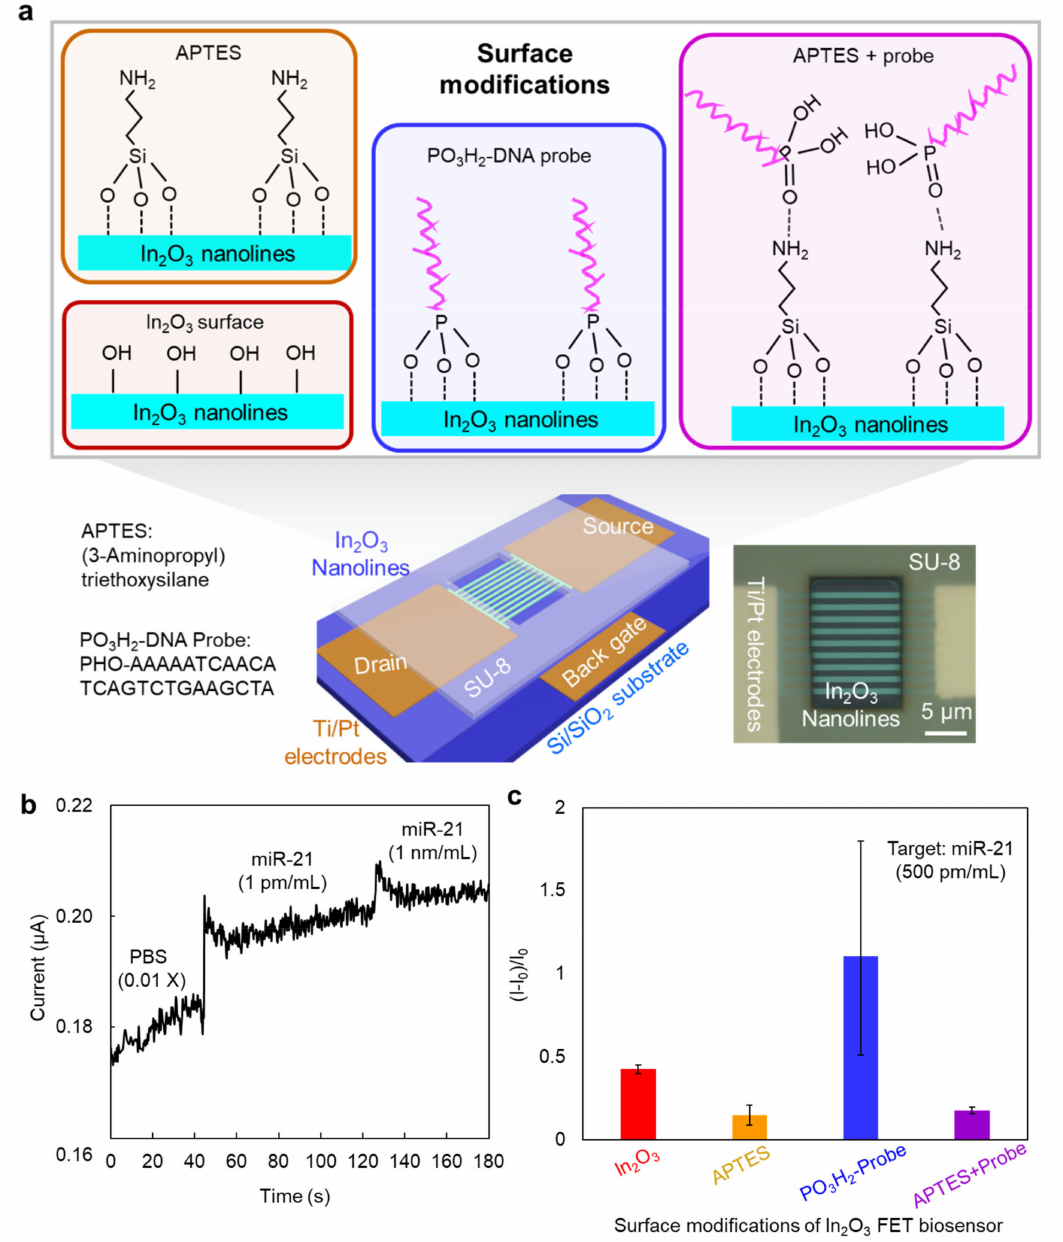
Figure 4. The In 2 O 3 nanolines FET sensing device. ( a ) Schematics of In 2 O 3 nanolines FET device and several surface modifications. The information of the APTES and DNA-probe is shown at the lower left. The microscope image of device is in bottom right. ( b ) Representative sensing response curve of DNA probe immobilized In 2 O 3 sensing device towards miR-21 target. The background solvent is diluted PBS solution (0.01 X). The concentration of miR-21 target is changed. ( c ) Sensing response of the sensors after various surface modifications. The concentration of miR-21 target is 500